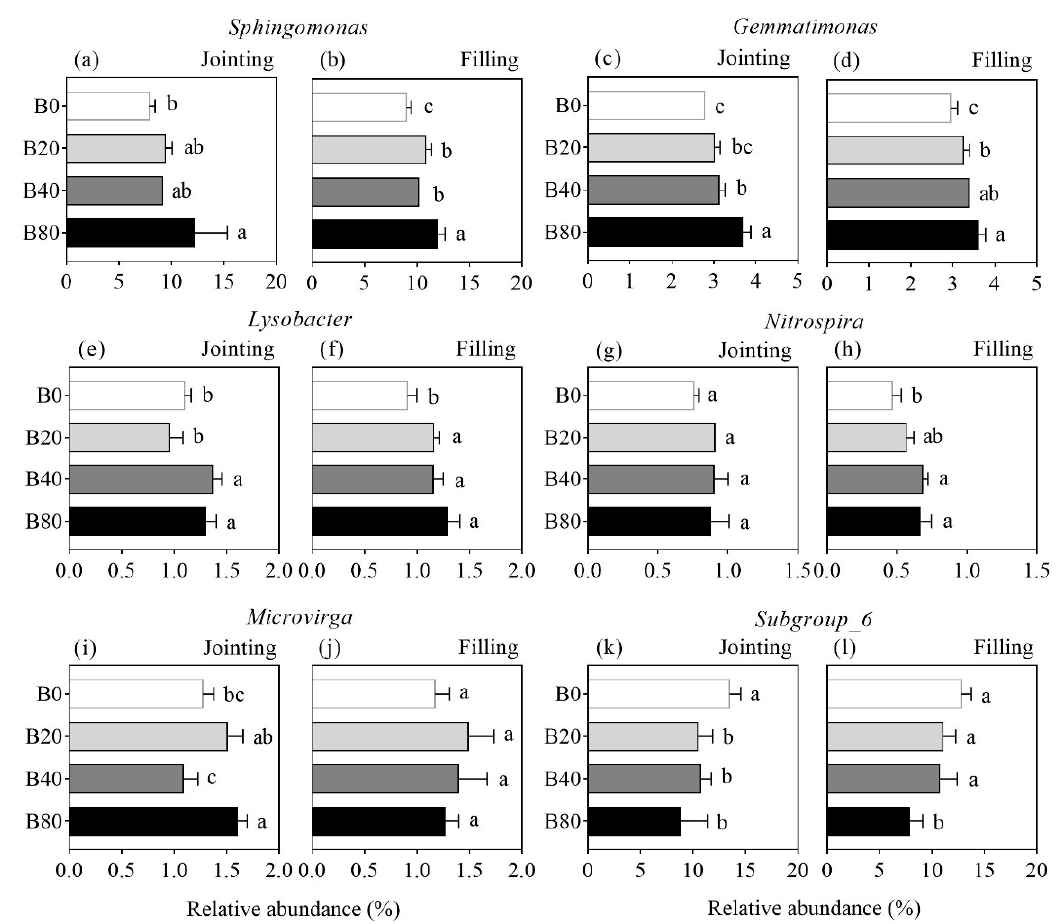
Figure 2. Effects of biochar on the relative abundance of soil bacterial genera. Note: Different letters indicate significant differences (one-way ANOVA, p < 0.05, Duncan analysis).